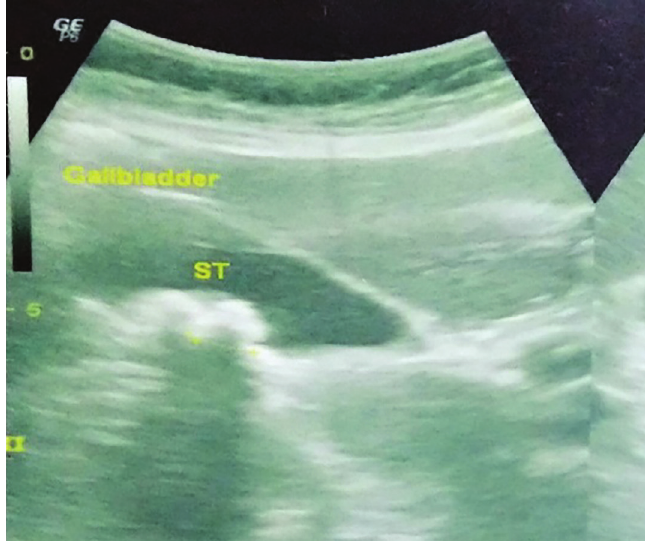
Figure 1. Two gallstones with the size of 9.5mm and 9.1mm were found in ultrasound